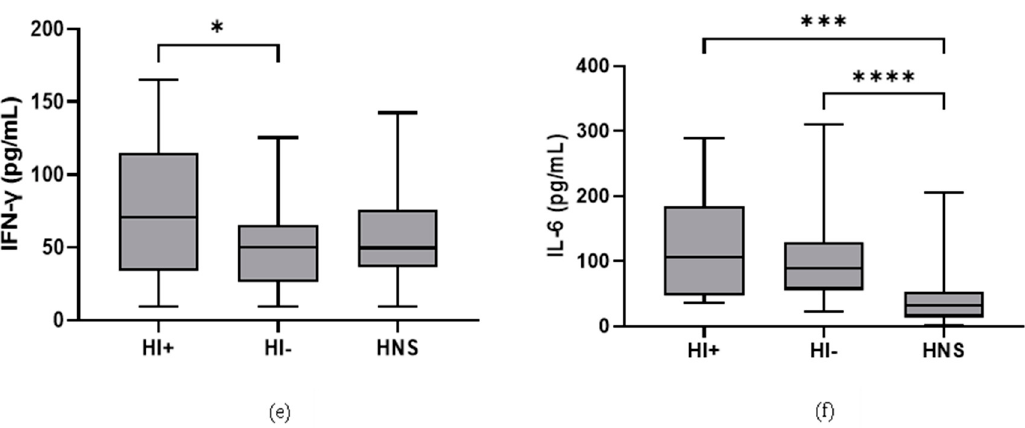
Figure 5. Sputum Biomarkers in COPD HI +ve, COPD HI − ve and HNS : ( a ) IL-1 β , data is presented as minimum, maximum and median concentrations, data analysed using Krushkal-Wallis test with Dunns post hoc test. ** p ≤ 0.01. ( b ) IL-4, data is presented minimum, maximum and median concentrations, data analysed using Krushkal-Wallis test with Dunns post hoc test. * p ≤ 0.05. ( c ) IL-8, data is presented as minimum, maximum and median concentrations, data analysed using Krushkal-Wallis test with Dunns post hoc test. * p ≤ 0.05, *** p ≤ 0.001. ( d ) Granulocyte colony stimulating factor (G-CSF), data is presented as minimum, maximum and median concentrations, data analysed using Krushkal-Wallis test with Dunns post hoc test. * p ≤ 0.05, ** p ≤ 0.01. ( e ) Interferon (IFN)- γ , data is presented as minimum, maximum and mean concentrations, data analysed using a one-way ANOVA test with Bonferroni post hoc test. * p ≤ 0.05. ( f ) IL-6, data is presented as minimum, maximum and median concentrations, data analysed using Krushkal-Wallis test with Dunns post hoc test. *** p ≤ 0.001, **** p ≤